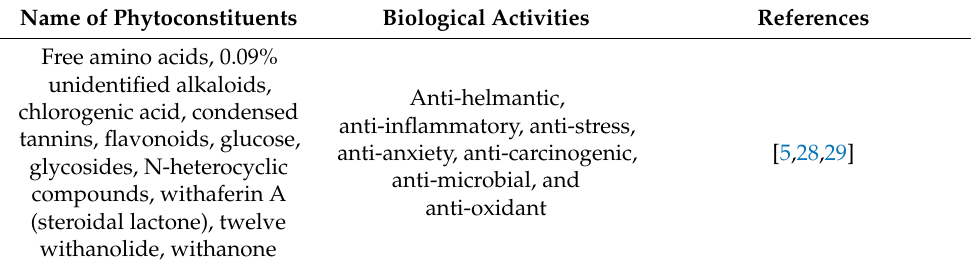
Table 2. Different biological compounds present in leaves and their activities.